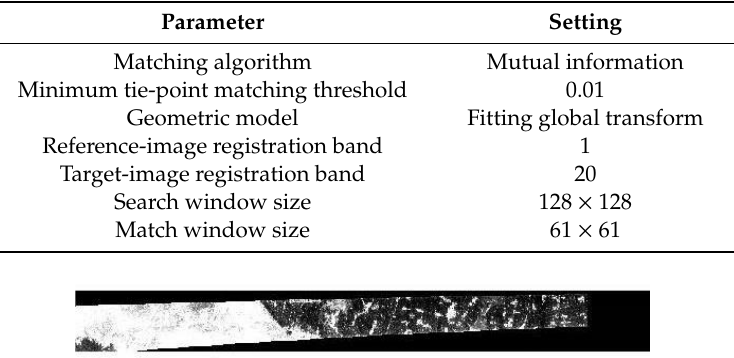
Figure 5. Hyperspectral CASI image after registration.